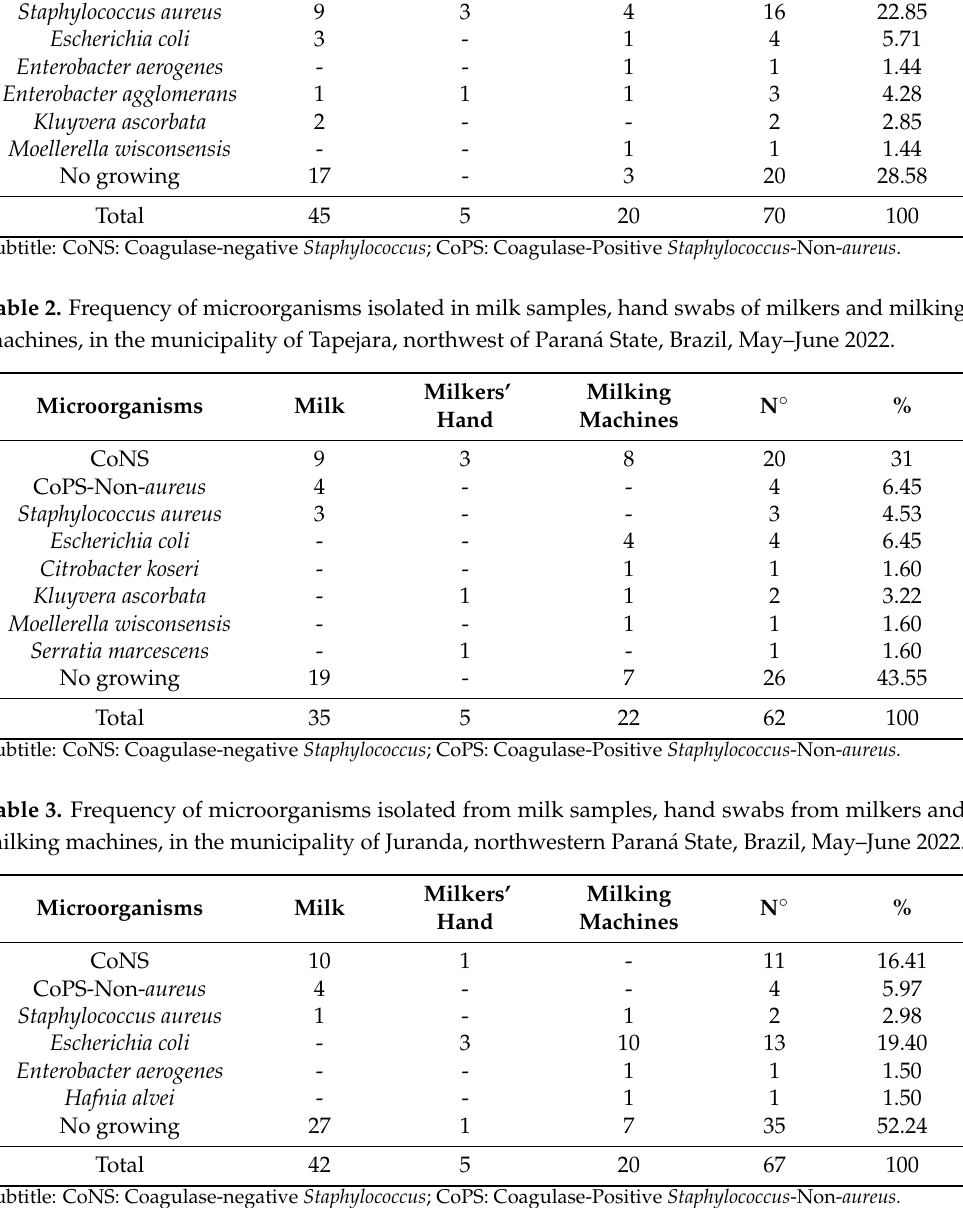
Milkers’ Milking Hand Machines